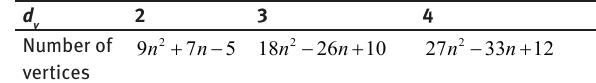
Table 4: The vertex partition of D